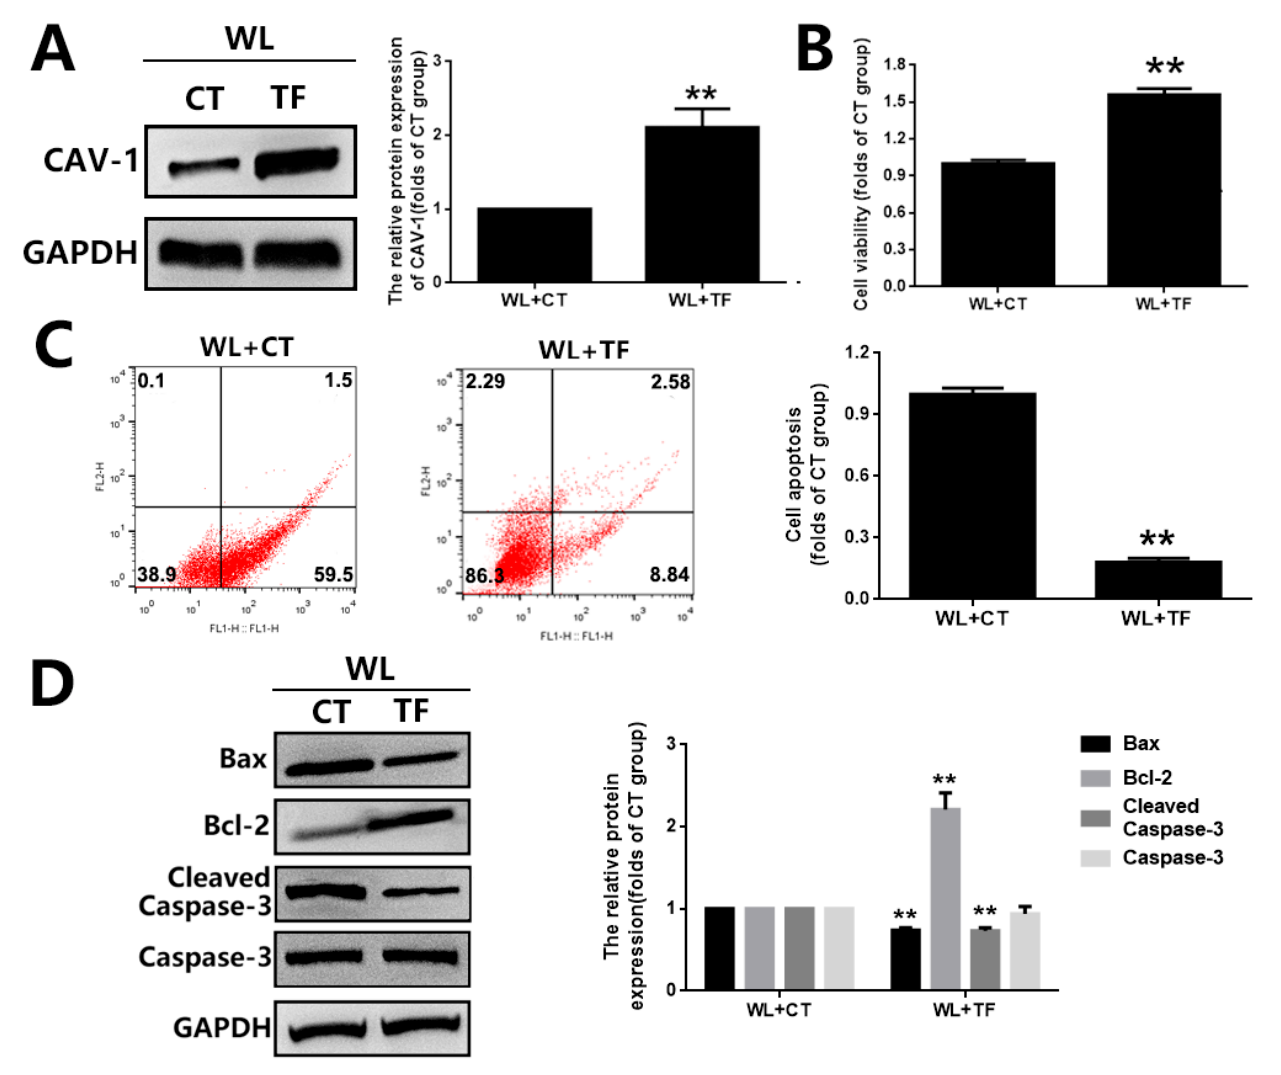
Figure 7. The effect of CAV-1 overexpression on photoreceptor degeneration in 661W cells exposed to WL illumination. ( A ) The overexpression of CAV-1 was verified by Western blot analysis. Cells from the 661W cell line overexpressing CAV-1 were exposed to WL (4000 lux) for 2 h. ( B ) Cell viability was assessed by MTT assay. ( C ) Cell apoptosis was analyzed by Annexin V-FITC and PI double-staining assay. Representative images of cell death profiles are shown on the left. The percentages of apoptotic cells are summarized in the right panel. ( D ) The expressions of apoptosis-related proteins (Bax, Bcl-2 and Caspase-3) were evaluated by Western blot analysis (left panel). The densitometry analysis of these proteins is shown in the right panel. ** p < 0.01 vs. WL + CT. WL: white light, CT: 661W cells without CAV-1 transfection, TF: 661W cells with CAV-1 transfection.